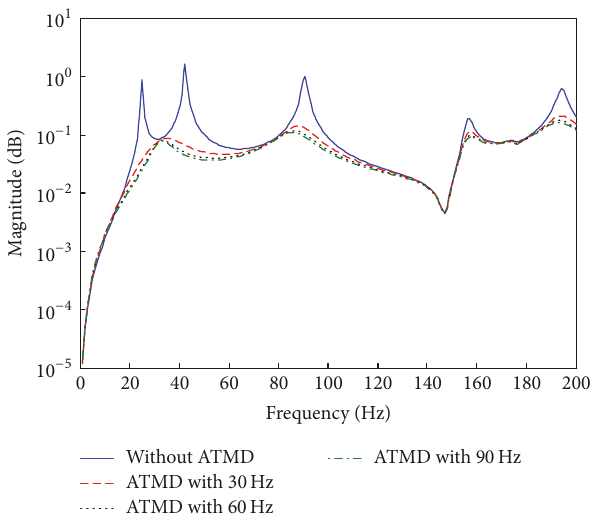
Figure 14: Vibration attenuation effect of the